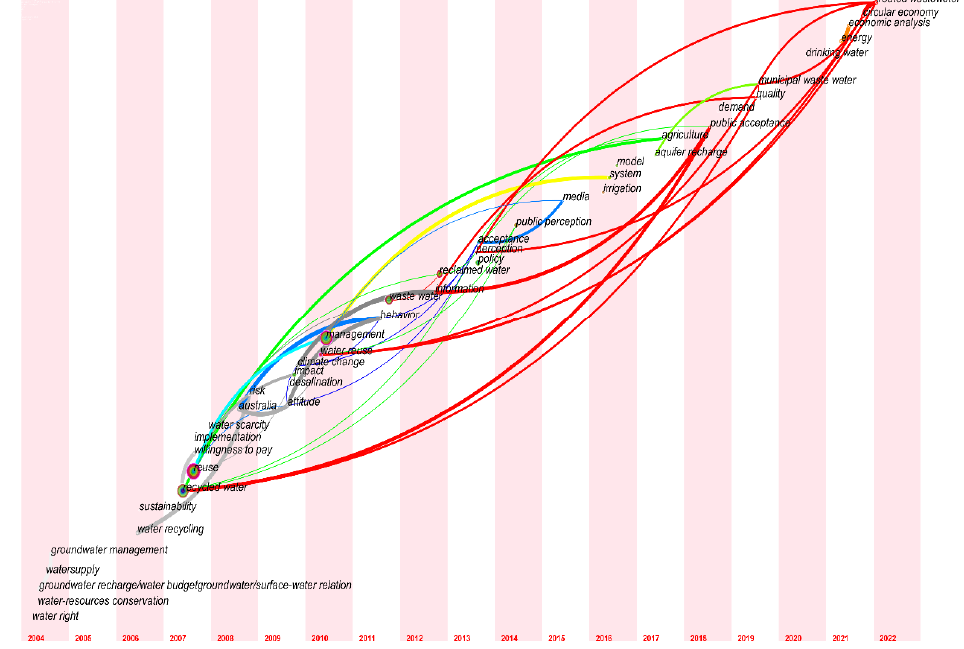
Figure 13. Time-zone map of research on reclaimed water utilization policies from WOS.